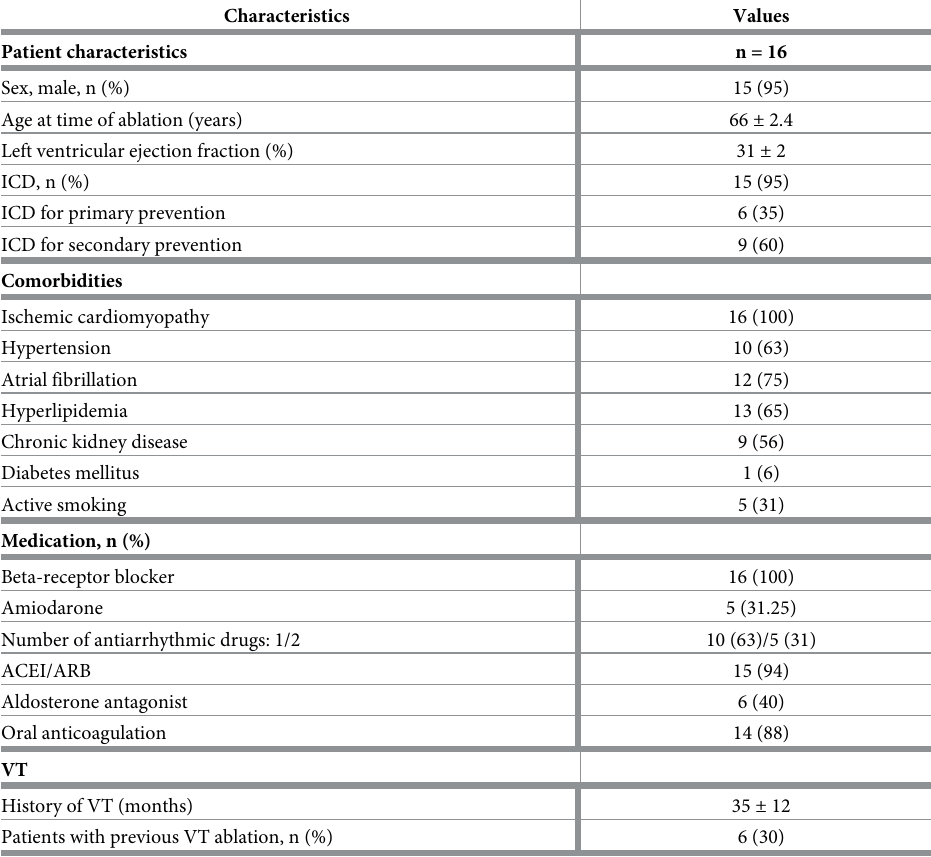
Table 1. Study population. Characteristics